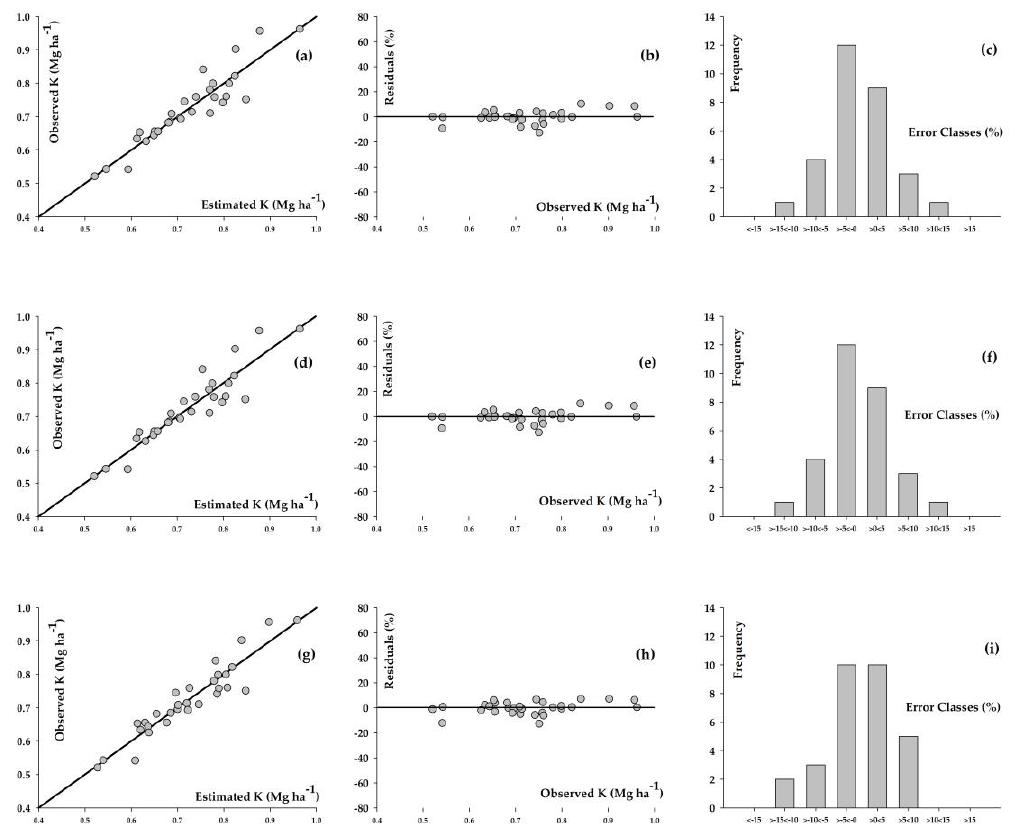
Figure 5. Dispersion of estimated value by observed value, dispersion of residues, and distribution in error classes obtained for potassium adjustments (Mg ha − 1 ) using non-linear models, where ( a – c ) refer to the Richards model, ( d – f ) to the Weibull model, and ( g – i ) to the Schumacher–Hall model. Table 9. Statistical parameters of the non-linear models obtained in the adjustment of the amount of calcium in the eucalypt stand.